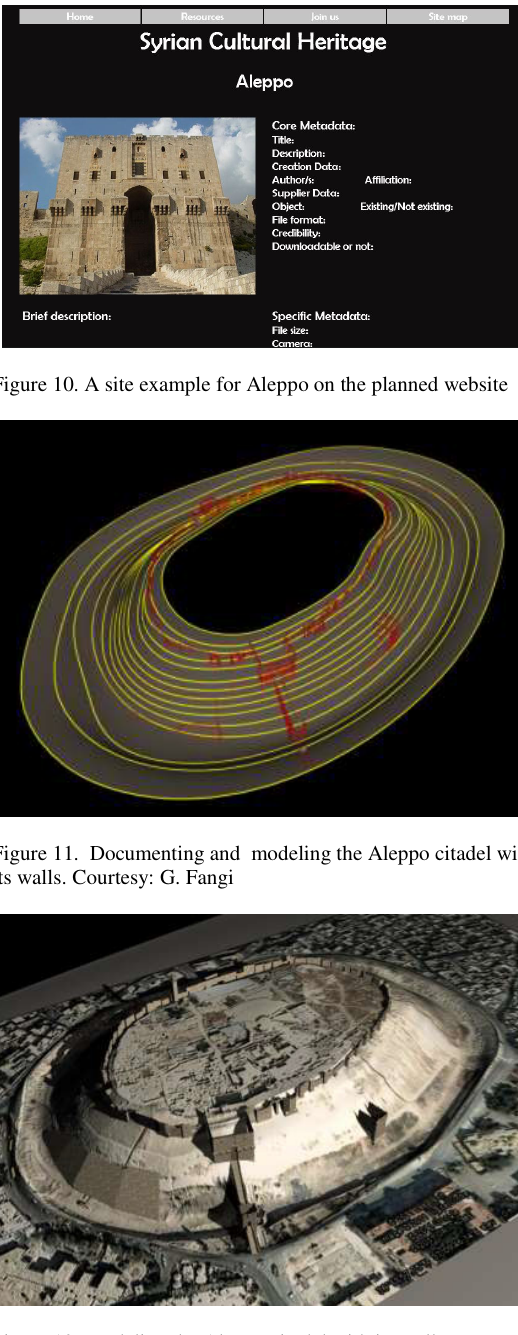
Figure 12. Modeling the Aleppo citadel with its walls. Courtesy: G. Fangi